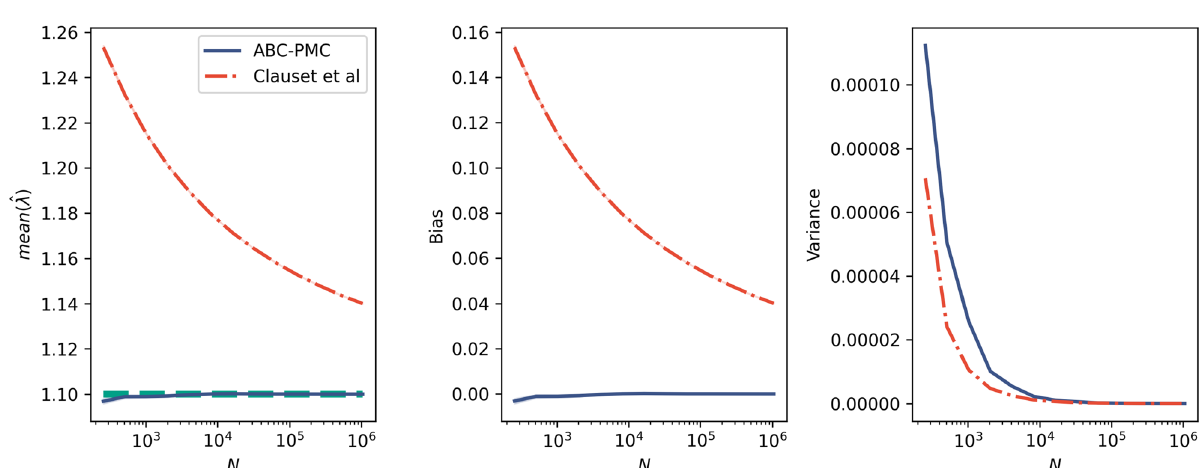
Figure 7. Bias in ABC (solid blue) vs Clauset et al.’s estimator (dashed red) for unbounded power laws. Rank- frequency data was generated for (cid:31) = 1.1 with varying sizes, N . This was run 100 times. The left figure shows the known (cid:31) against the mean estimated (cid:31) . The centre figure shows the mean bias, with a 68% confidence interval shaded. The right figure shows the variance of the estimators. The bias is much lower with ABC. The ABC estimator has higher variance than Clauset et al. at low N, although the variance is still very